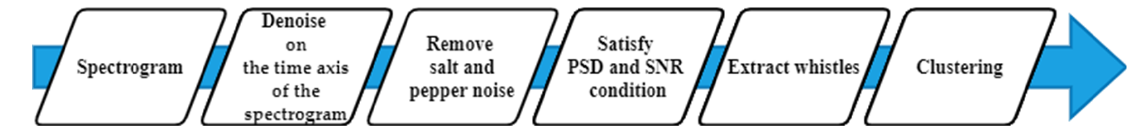
Figure 1. Whistle detector algorithm flow chart.